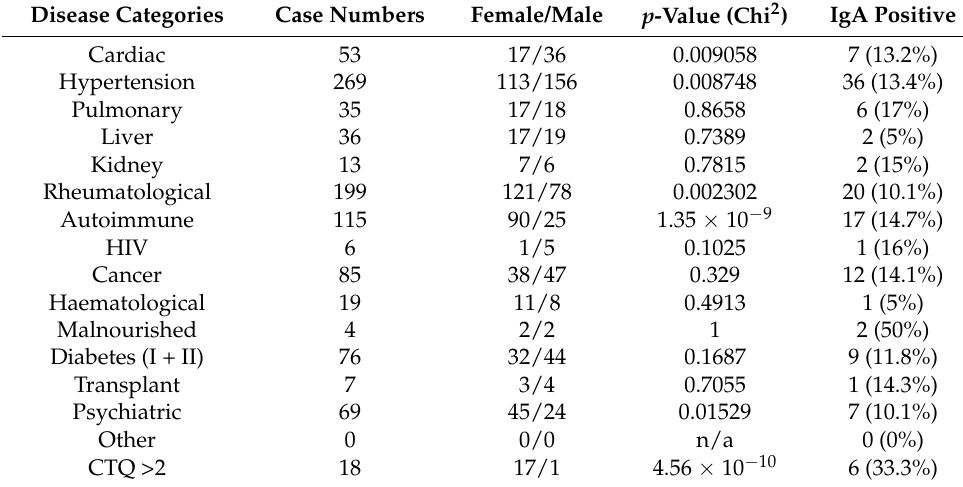
Table 2. Number of participants with each of the participant-reported